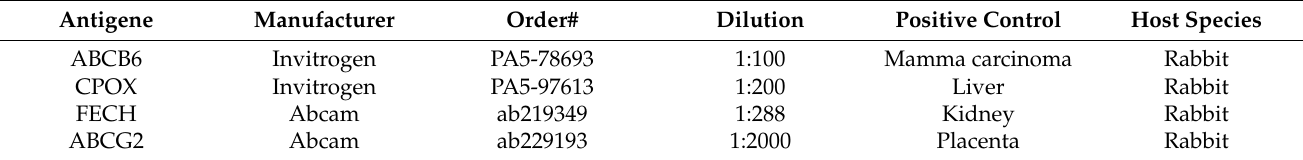
Table 1. Summary of the antibodies and controls used for immunohistochemical